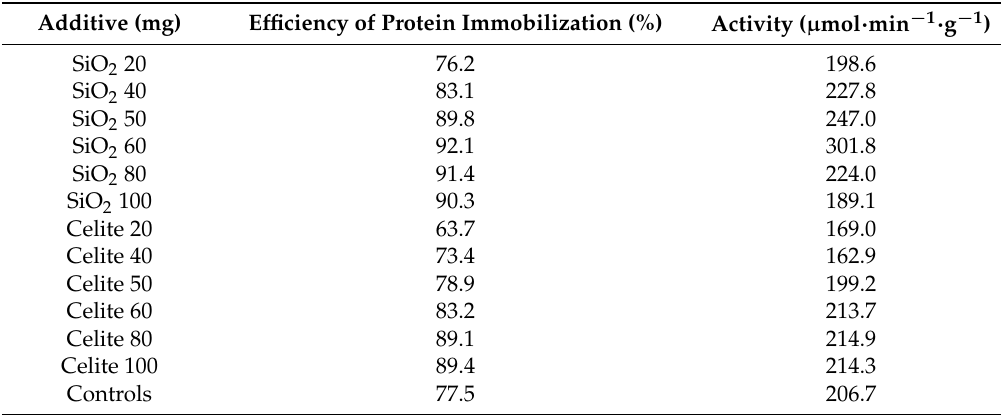
Table 2. The effect of additives on the activity and efficiency of protein